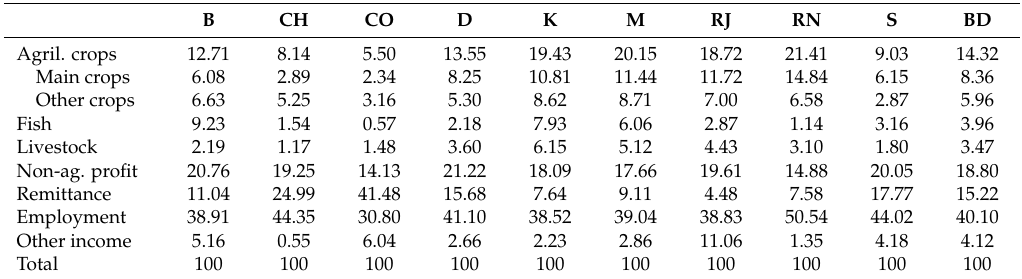
Table 1. Each income sector’s share in total household income (%), by region. B CH CO D K M RJ RN S BD Agril. crops